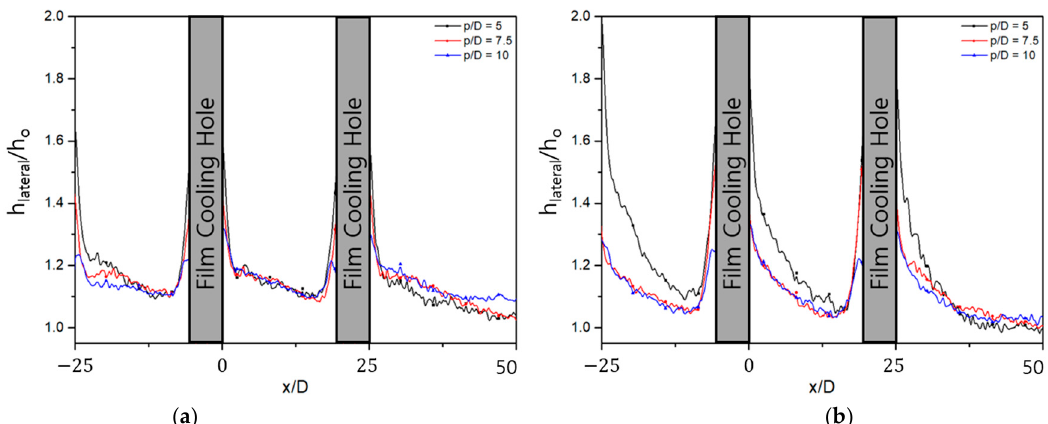
Figure 8. h lateral /h o for different hole pitch cases: ( a ) M = 1.0; and ( b ) M = 2.0.